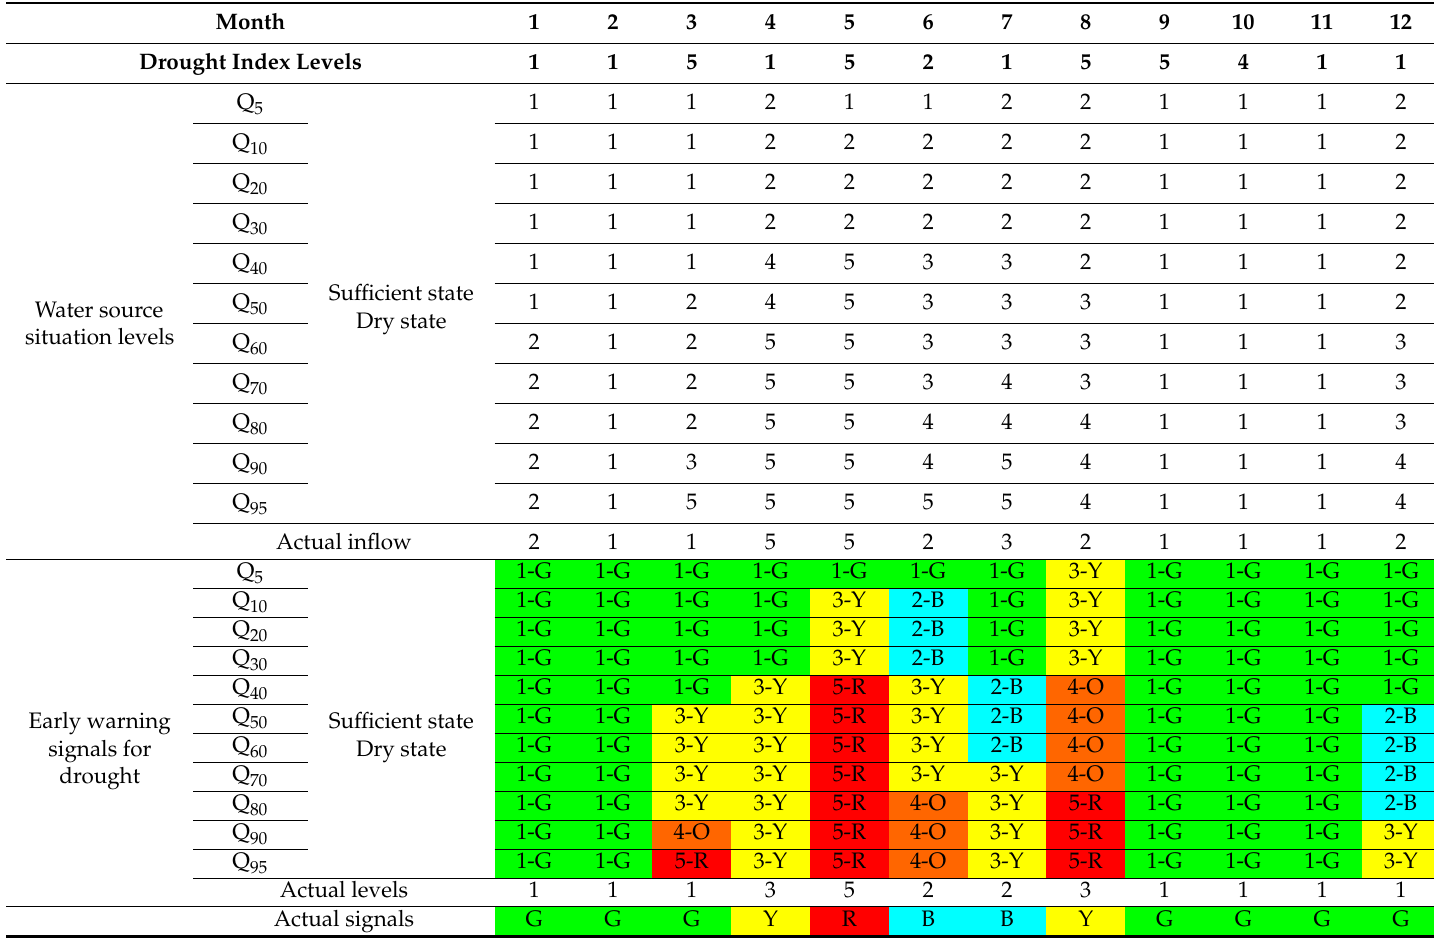
Table 13. Early Drought Warning Results for the Irrigation Area in